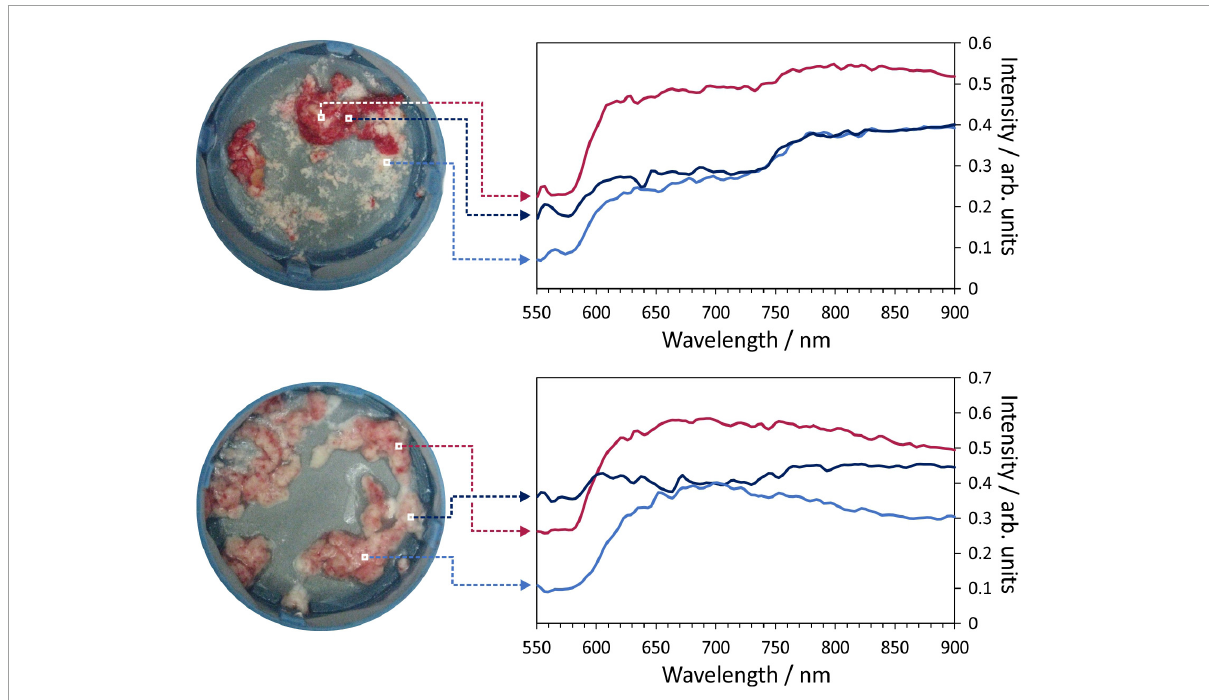
FIGURE3 Example hyperspectral images for two thrombus samples. Each image pixel contains a 150-wavelength reflectance spectrum which characterises the composition of the material being imaged. Example spectra for the marked pixels are shown on the right of the